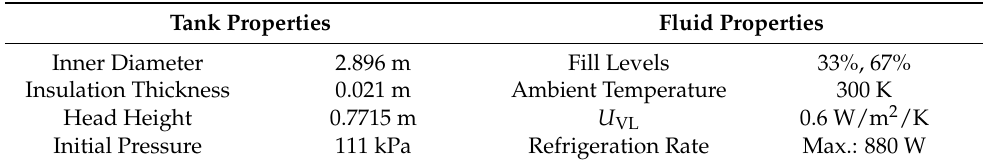
Table 1. At the initial tank pressure of 111 kPa, hydrogen has a saturation temperature of 20.6 K and para-hydrogen content of 99.8%. Table 1. LH 2 tank dimensions and simulation